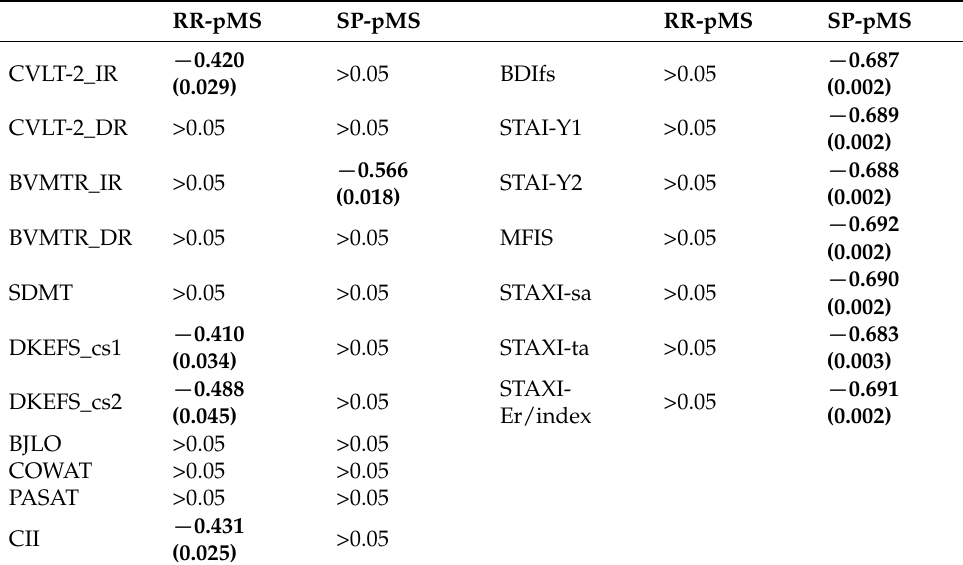
Table 3. Pearson correlation coefficient and effect size between RMEt performance and cognitive and mood aspects for both RR-pMS and